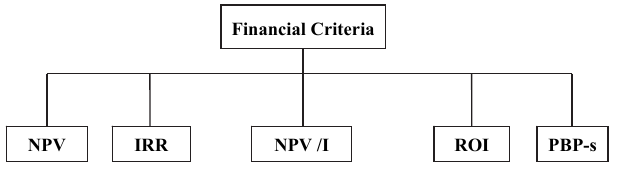
Fig. 4. Hierarchy structure for determining weights of financial